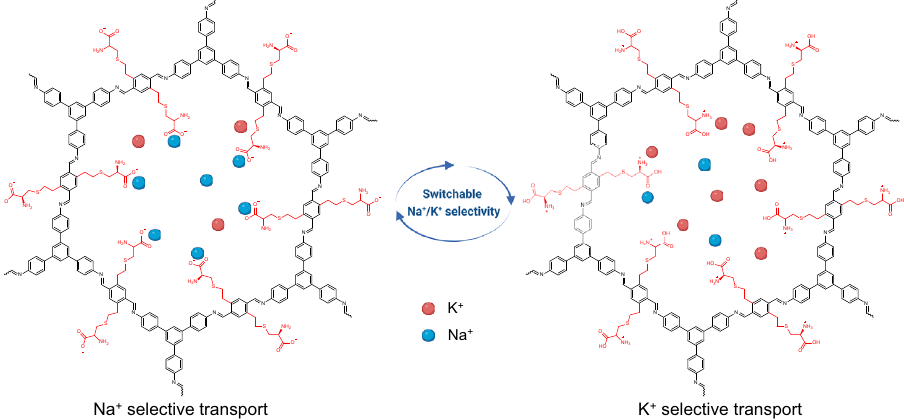
Fig. 1 | Switchable Na + /K + selectivity. Switchable Na + /K + selectivity enabled by a cysteine functionalized COF membrane. Red and blue balls refer to K + and Na + ,